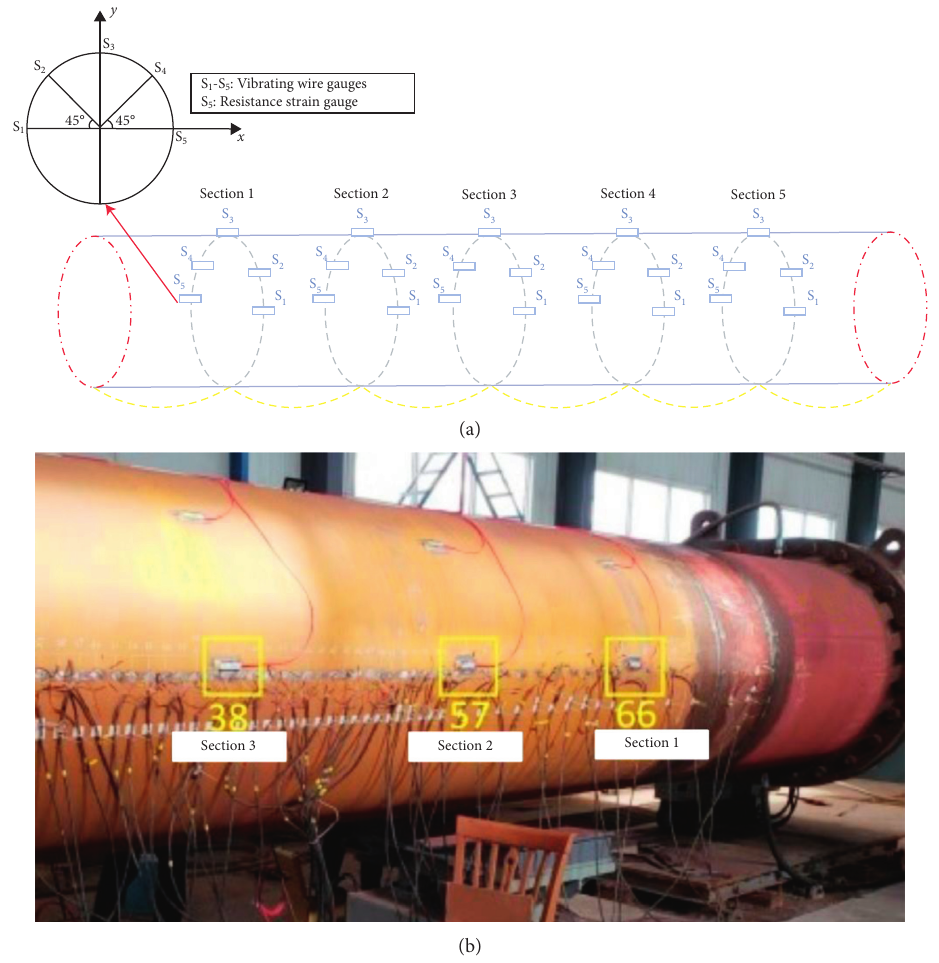
Figure 5: Arrangement of vibrating wire gauges and electrical resistance strain gauge: (a) schematic diagram; (b) site layout.